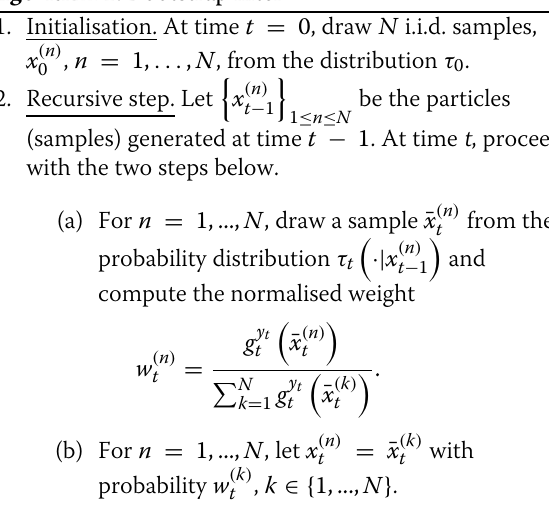
Algorithm 1: Bootstrap